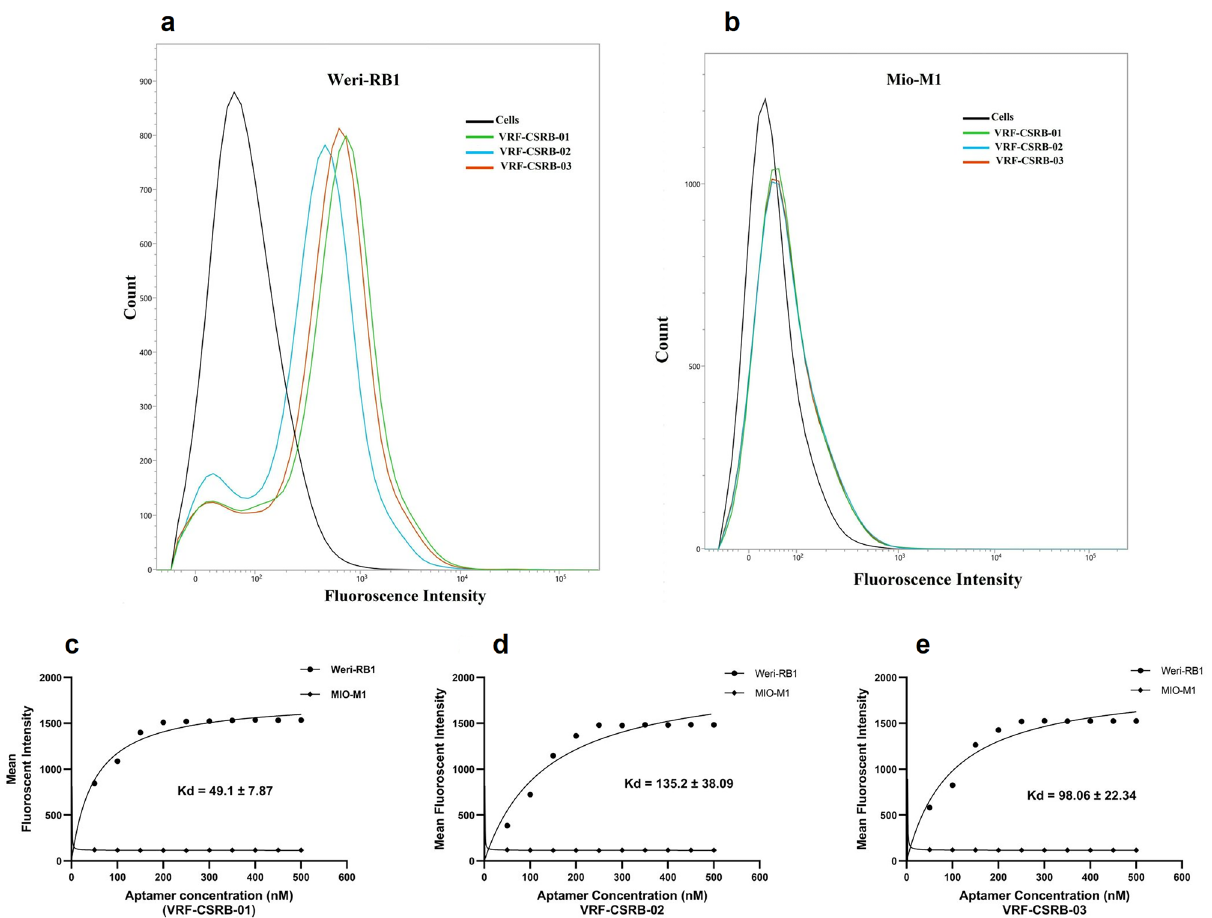
Figure 3. Binding ability and dissociation constants of selected aptamers. ( a ) Binding ability of FITC-labelled aptamers VRF-CSRB-01, VRF-CSRB-02 and VRF-CSRB-03 on Weri-RB1 cells assessed by flow cytometry. ( b ) Binding ability of FITC-labelled aptamers VRF-CSRB-01, VRF-CSRB-02 and VRF-CSRB-03 on Mio-M1 cells assessed by flow cytometry. ( c – e ) Binding curve of aptamers VRF-CSRB-01, VRF-CSRB-02, and VRF-CSRB-03 with Weri-RB1 and Mio-M1 cells. The cells were incubated with increasing concentrations of FITC-labelled aptamers and assessed by flow cytometry. Equilibrium dissociation constants (Kd) (nM) were calculated using GraphPad Prism 7, under the non-linear fit model, one-site non-competitive binding to fluorescent population ratio at used aptamer